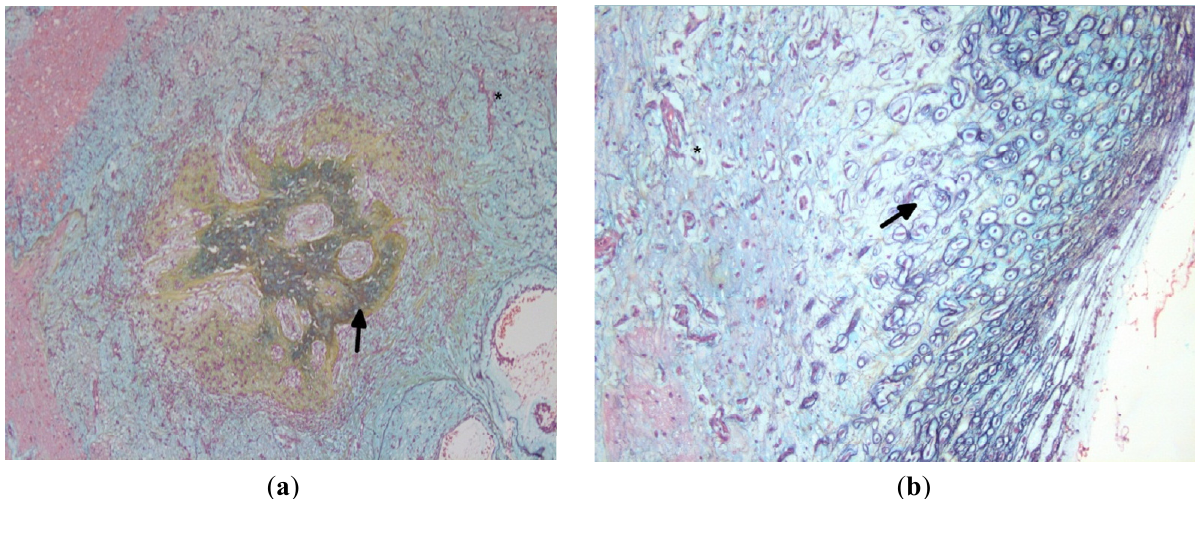
Figure 8. ( a ) Section shows bone (black arrow) in myxoma (asterisks); ( b ) Section shows cartilage (black arrow) in myxoma (asterisk). (Stain ( a , b ): Movat pentachrome; Original magnification: ( a ) ×5; ( b )